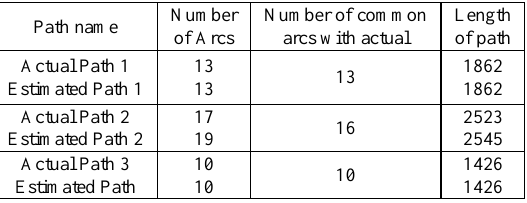
Table 5. Assessing results by proposed conditions It is only in rare cases that are extraordinarily high density of network lines would be a little out of the